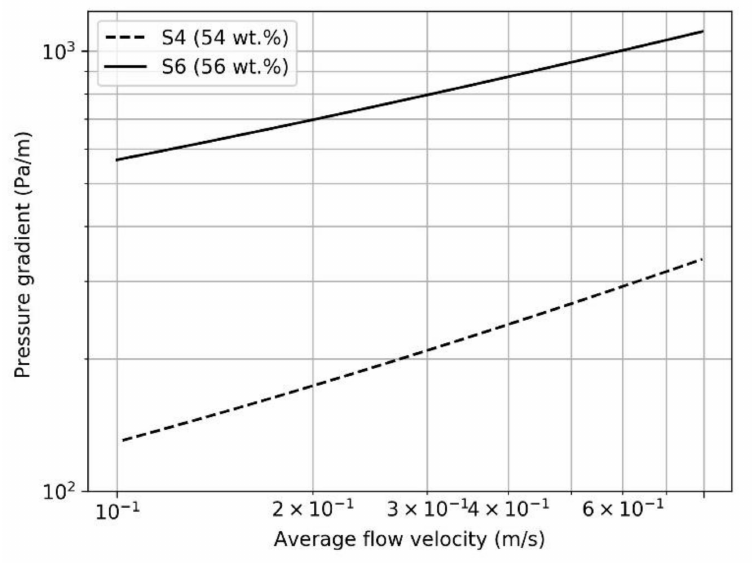
Figure 8. Pipe pressure loss analysis of the Herschel–Bulkley model for S4 and